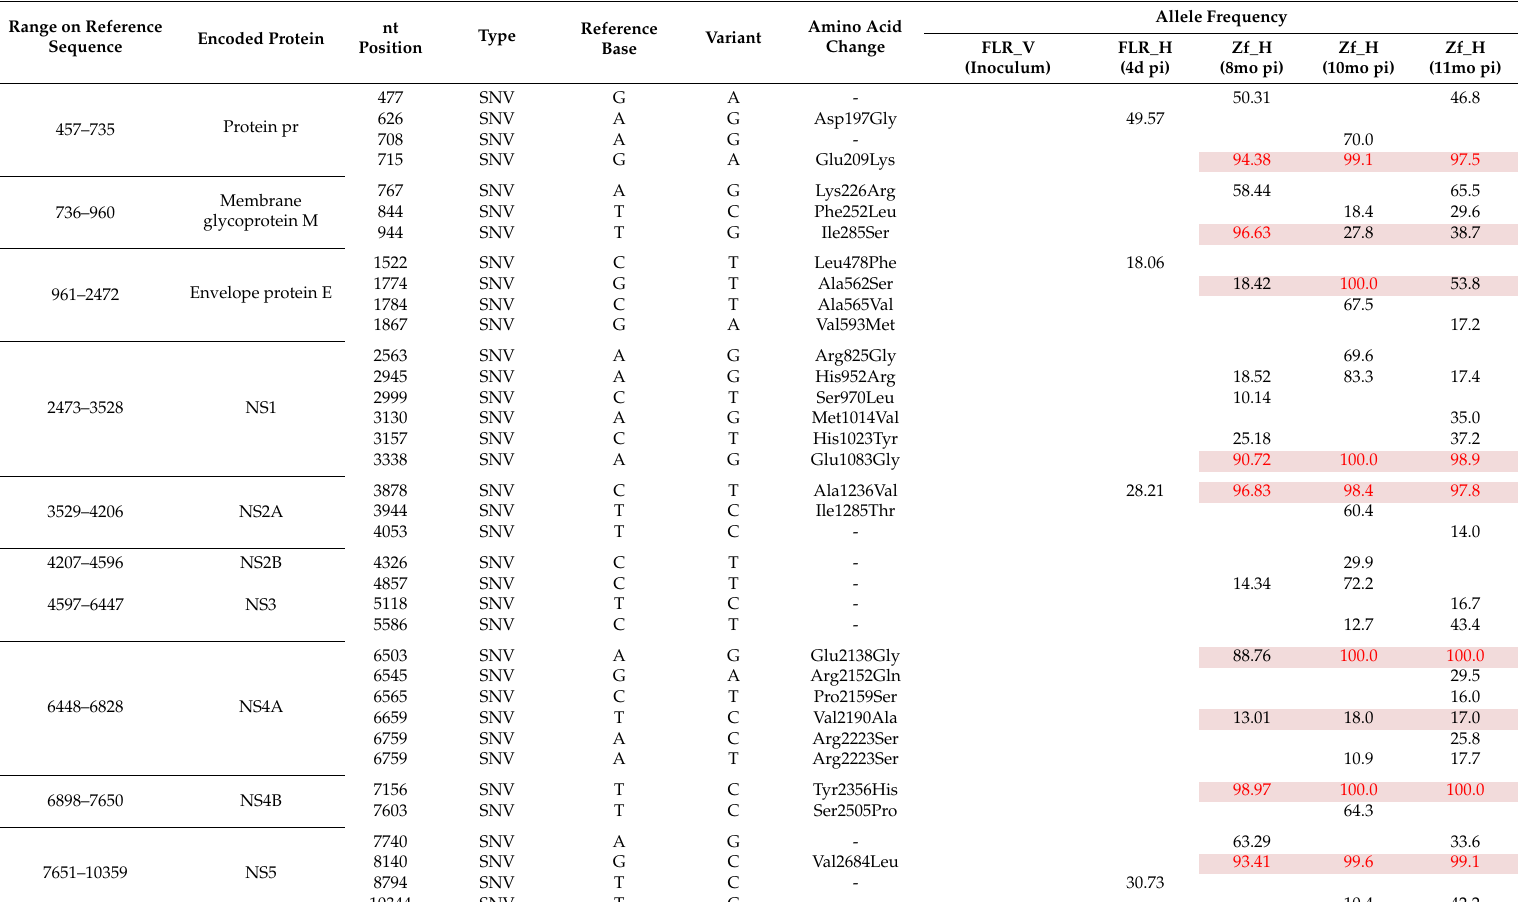
Table 2. Summary of ZIKV RNA genomic variants bearing sequence changes in structural proteins identified in the inoculum FLR ZIKV and ZIKVs produced by acutely and persistently FLR ZIKV-infected HEK293 cells on the structural protein genes in comparison with the reported FLR reference genomic sequence. Range on Reference